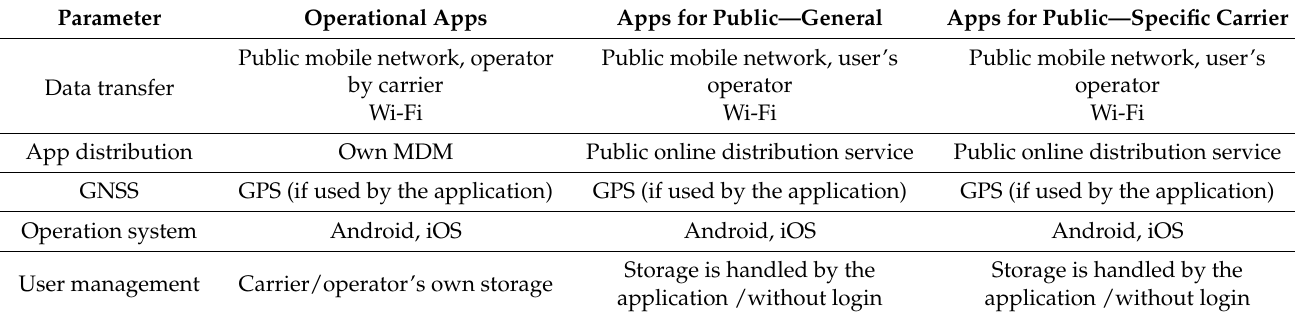
Table 1. Key parameters for the main types of mobile